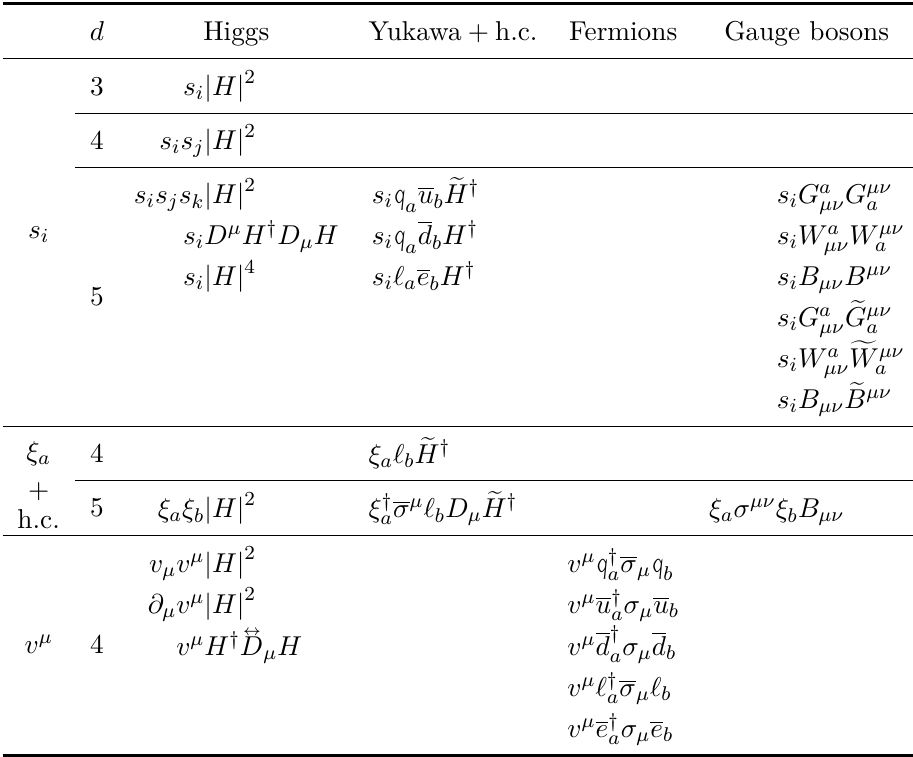
= ( ν , e ) T and a a a